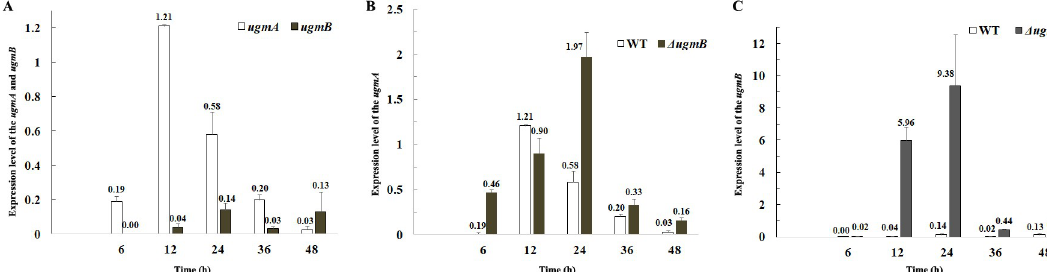
Fig 5. Expression of the ugm genes in the WT and mutant strains. Freshly harvested conidia were cultured in the PDB medium for 6, 12, 24, 36 and 48 hours. The hyphae were harvested and ground under liquid nitrogen. RT-PCR analysis was performed as described in Materials and methods. In A, expression level of the ugmA and ugmB in the WT strain; in B, expression level of the ugmA in the Δ ugmB mutant; and in C, expression level of the ugmB in the Δ ugmA mutant. All reactions were performed in triplicate. The relative mRNA expressions were calculated according to 2 - ΔΔ Ct with the transcription elongation factor gene (EF) as the reference.